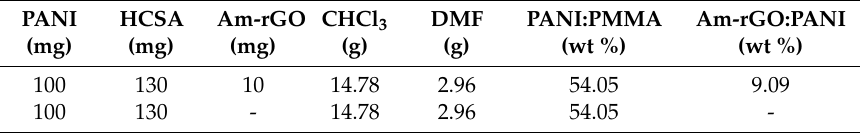
Table 1. Composition of electrospun PANI/PMMA/Am-rGO and PANI/PMMA solutions.